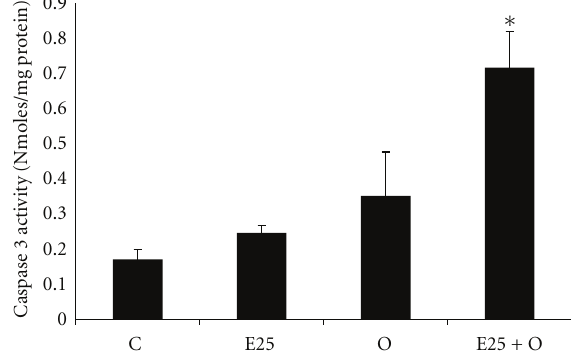
Figure 7: Ethanol and oleate-induced apoptosis in polarized hepatoma cultures. WIF-B cells were cultured for 48 hours in the absence (control media, C) or presence of 25mM ethanol (E25) with or without the presence of 0.5mM oleic acid (O and E25 + O). Apoptotic cell death was measured by spectrofluorometric detection of caspase-3 activity. Results are expressed as nanomoles of detected fluorometric substrate (AMC) cleaved and released by active caspase-3 enzyme per mg protein for four independent experiments. ∗ Significantly di ff erent ( P < 0 . 05) from control